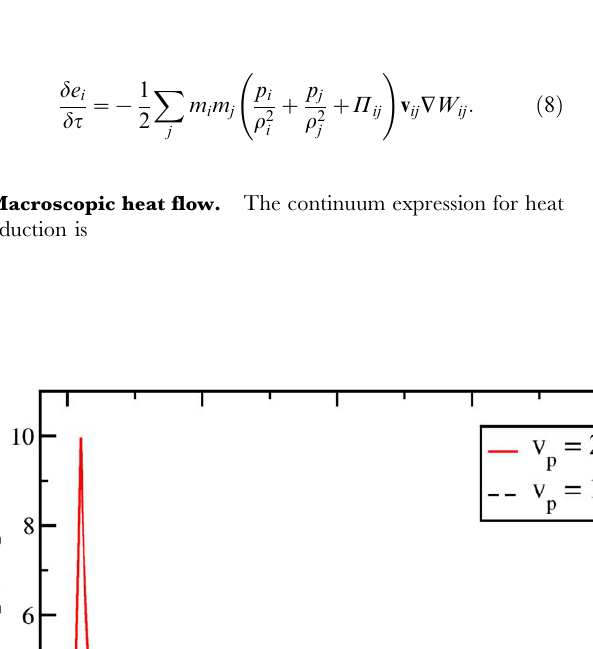
Figure 8. Shock compression of the simulation domain shown in Fig. 7. Starting from an initial mass density r 0 ~ 1000 kg/m 3 , a shock discontinuity with speed v d ~ 3036 m/s compresses the system into the Hugoniot state with r ^ 1650 kg/m 3 . Two different points in time are shown. The peak in the red curve stems from the hydrocarbon tails within the lipid bilayer, which have a lower compression modulus than water.